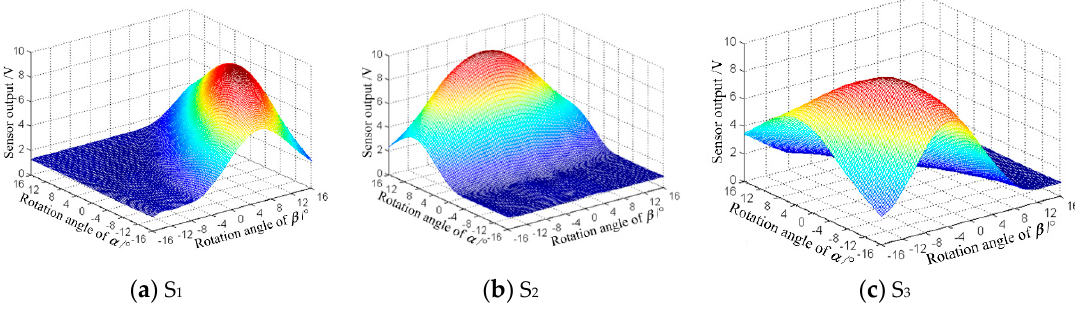
Figure 13. Measured voltage value of the eddy current sensors.